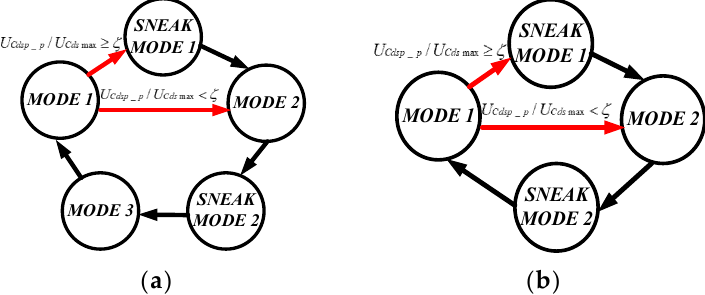
Figure 9. Operation mode conversion diagrams of the converter under two operating modes. ( a ) The modes of the converter in DCM (discontinuous conduction mode) mode. ( b ) The modes of the converter in CCM (continuous conduction mode) mode.